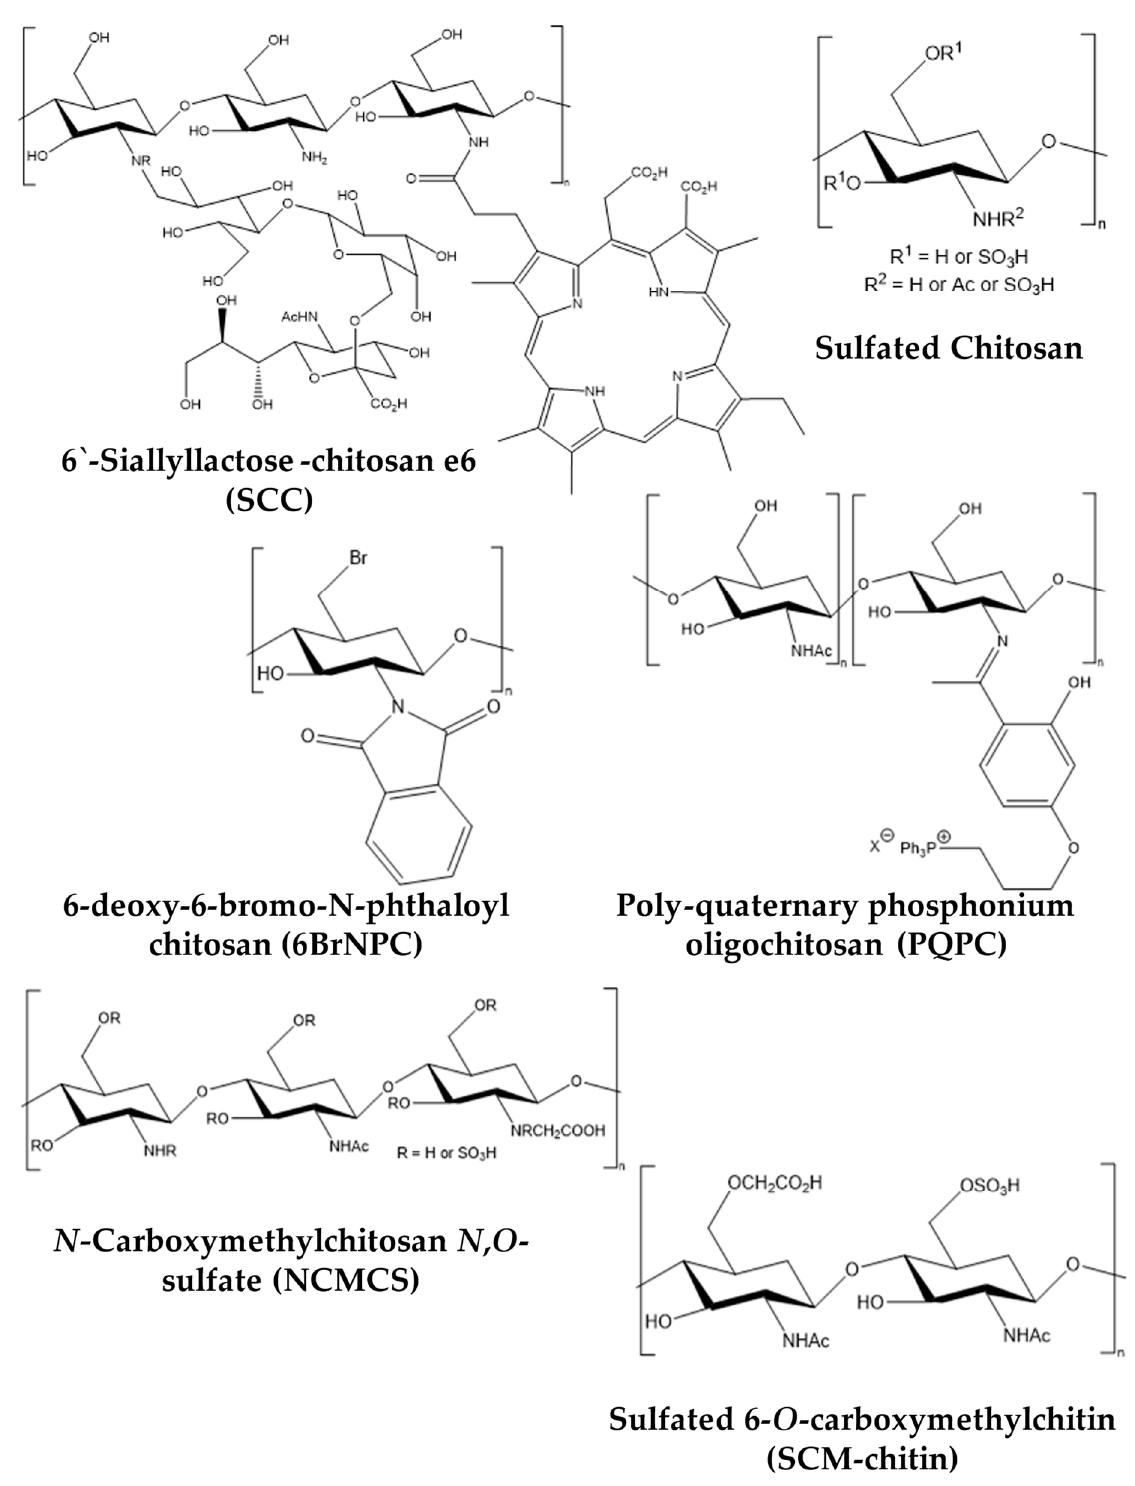
Figure 1. Chitosan derivatives that have been confirmed for their antiviral activity. A study of the Moloney murine leukemia virus with heparan sulphate receptor in- vestigation on SC-1 and NIH-3T3 cell lines concluded that sulphate replacement on C 4 H 6 O 4 of succinyl chitosan structure exhibited a reasonable inhibitory effect out of dex- tran sulphate chitosan matrices as a positive control. The antiviral efficacy was observed to get higher with molar mass and degree of sulphate substitution [92]. Nishimura et al.